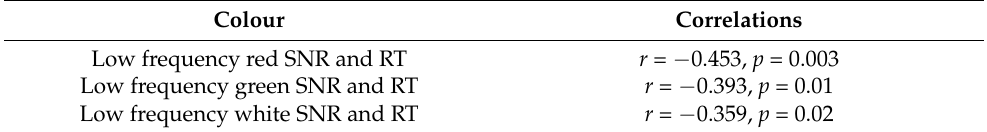
Table 7. SNR correlations for the three colors at low frequency and reaction time (RT) at CPT-II task.